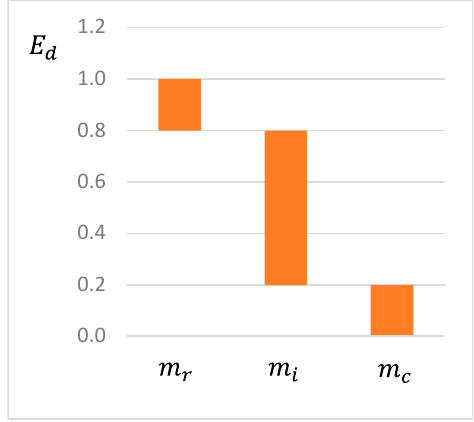
Figure 3. The relationship between E d and State.